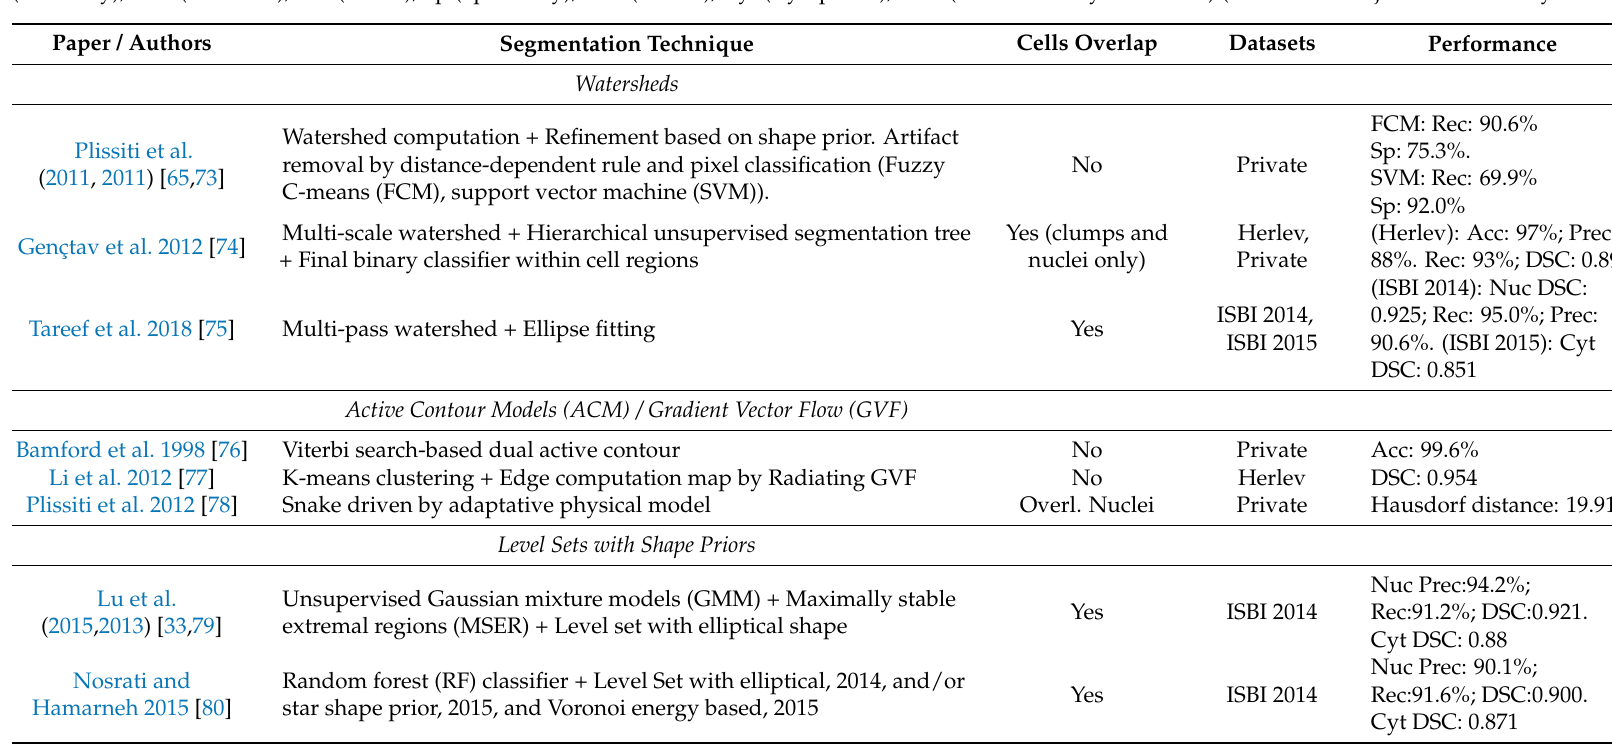
Table 3. Summary table with highlighted works on cervical cells segmentation. When more than one dataset was used, performance is given only on the public datasets for comparison purposes. Extension works presented by the same author/group are in the same row, with the performance being given for the best case. Acc (Accuracy), Prec (Precision), Rec (Recall), Sp (Specificity), Nuc (Nuclei), Cyt (Cytoplasm), DSC (Dice similarity coefficient) (same as ZSI-Zijdenbos similarity